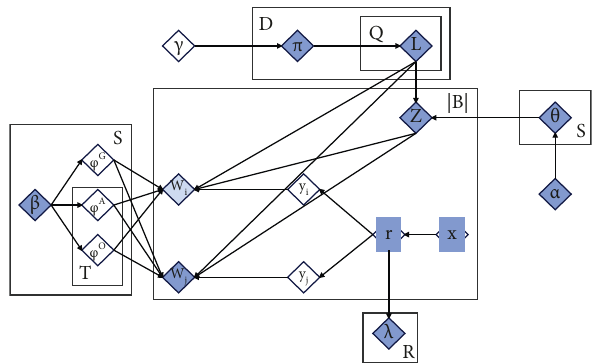
Figure 5: Graphical representation of the Maxent-JAWSTM